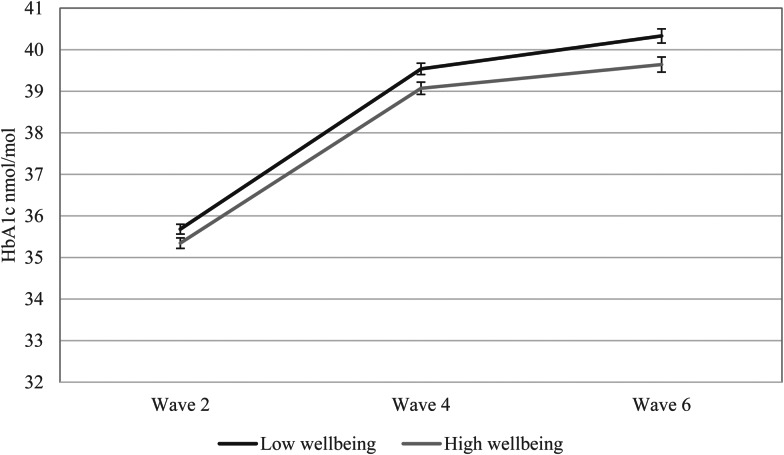
The trajectory of HbA1c over time by wave 2 wellbeing status (CASP-19) (N = 1744). N.B. Bars indicate standard error of the mean. Age- and sex-adjusted model. HbA1c, glycated hemoglobin.